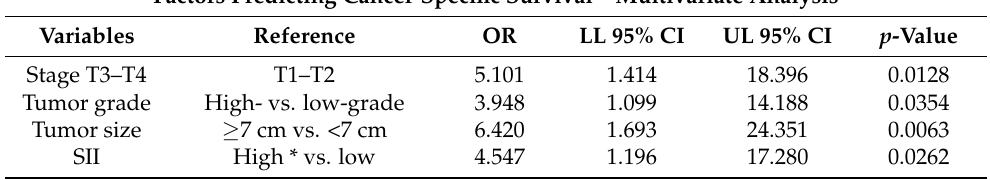
Table 3. Multivariate analyses of factors predictive for cancer-specific survival in patients with clear cell renal cell carcinoma (ccRCC).